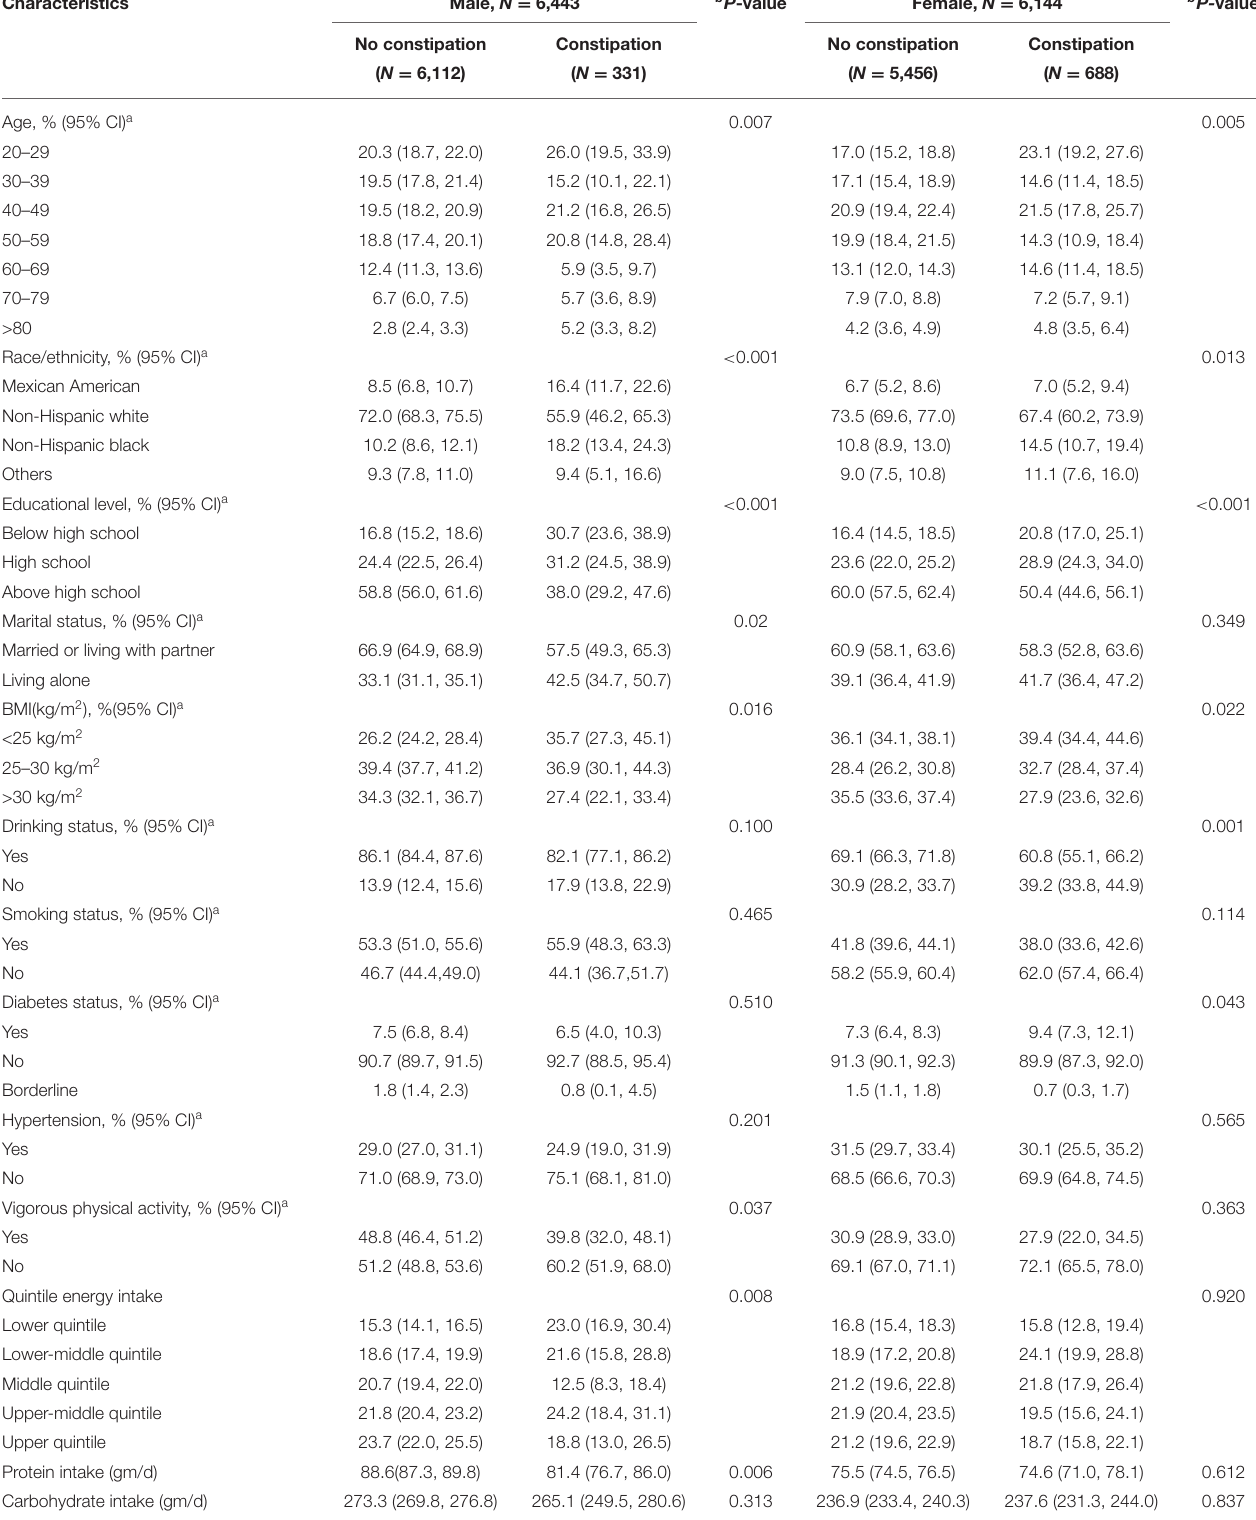
TABLE 1 | Participant characteristics by constipation among men and women from National Health and Nutrition Examination Surveys (NHANES) 2005–2010.